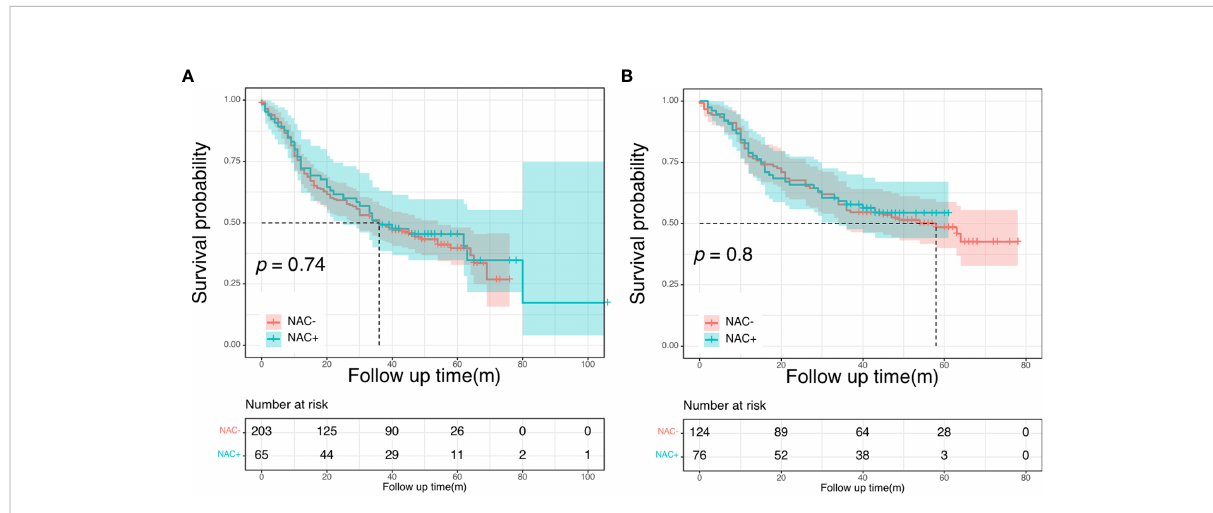
FIGURE 5 Disease-free survival curves in the NCC cohort: in the entire cohort (A) ; in the propensity score-matched cohort (B)